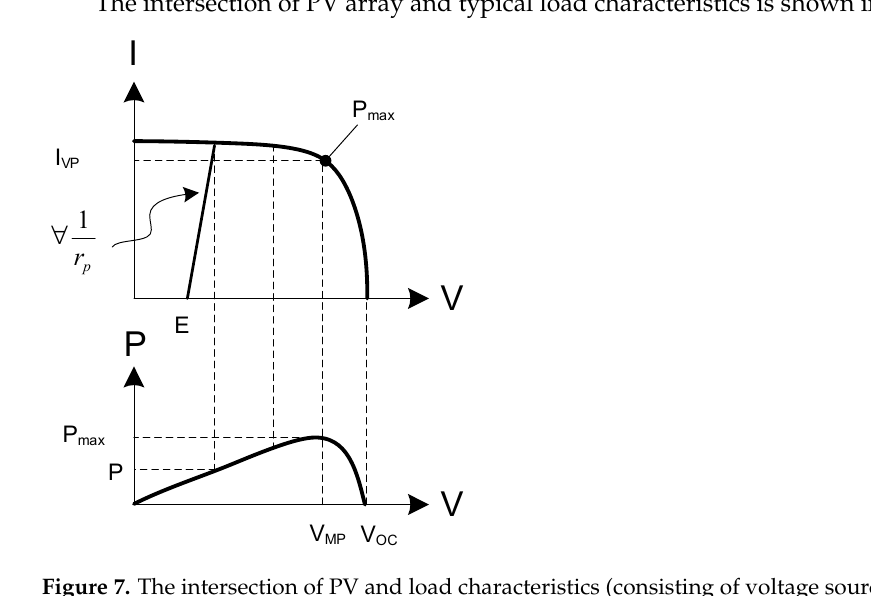
Figure 7. The intersection of PV and load characteristics (consisting of voltage source and resistive element r p ) in a direct source–load connection.